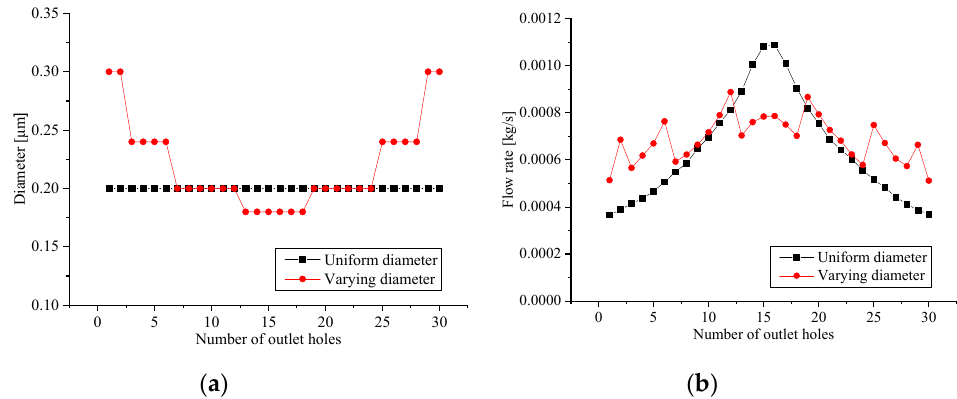
Figure 11. Comparison of uniform-diameter and varying-diameter cases: ( a ) Distribution of the diameter; ( b ) distribution of the flow rate. Table 5. Relationship between varying diameter and applied voltage.